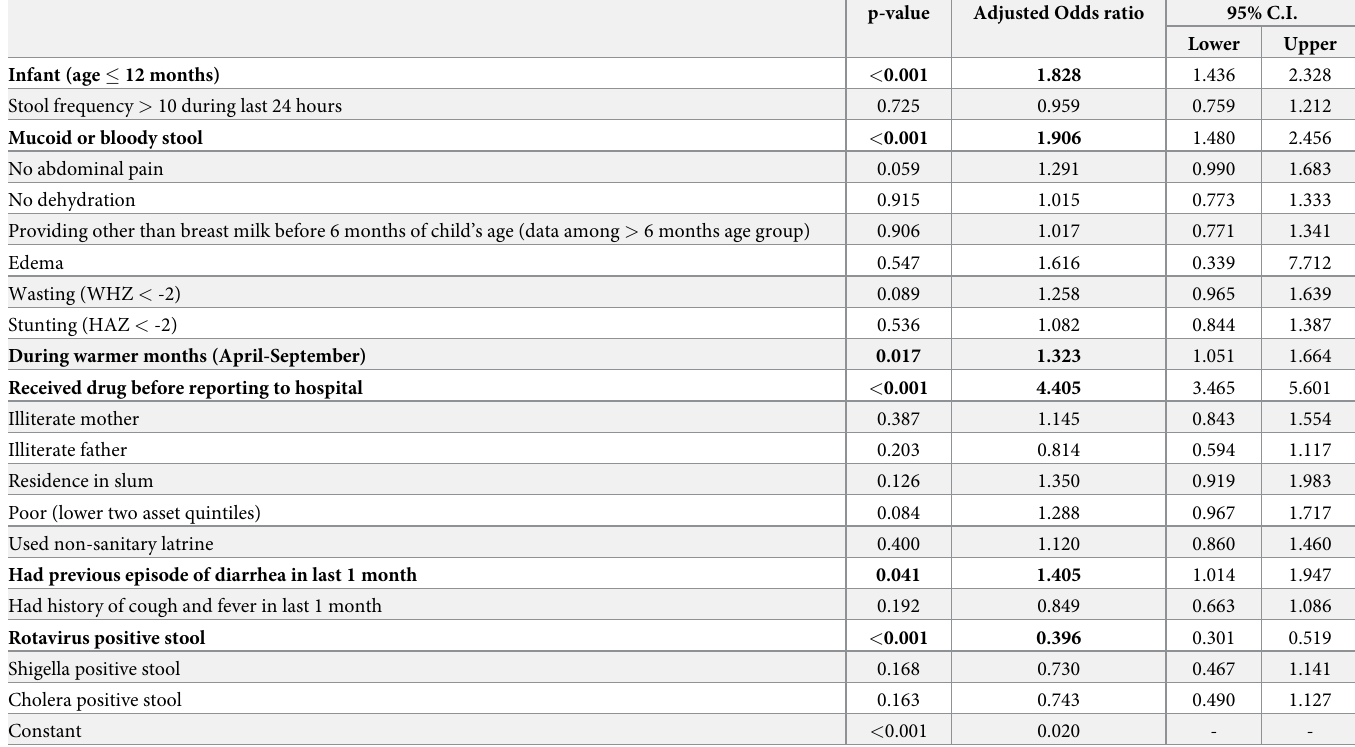
Table 2. Associated or risk factors of prolonged diarrhea (ProD) (diarrhea for > 7 to 13 days) and acute diarrhea (AD) (diarrhea for � 7 days) by logistic regression (enter